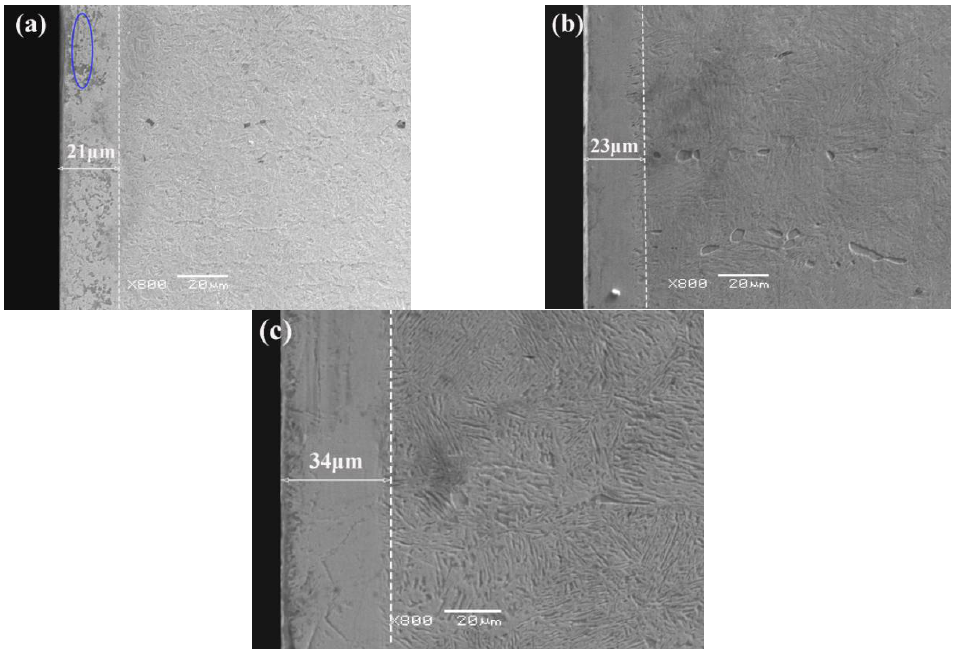
Figure 4. Microstructure of plasma nitrided layer on AISI 430 ferritic stainless steel with a different initial microstructure. ( a ) DN450-8, ( b ) SN450-8, and ( c ) AN450-8. initial microstructure. ( a ) DN450-8, ( b ) SN450-8, and ( c )